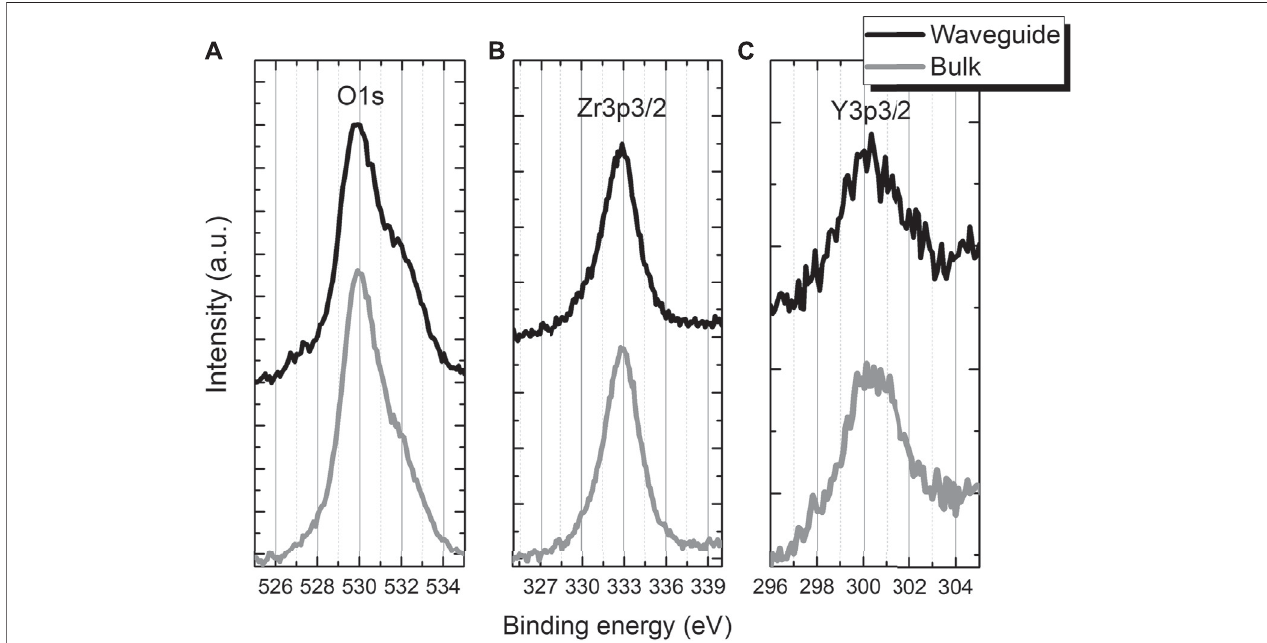
FIGURE 10 | X-ray photoelectron spectra of the nc-YSZ ceramic for both the laser irradiated (waveguide) and the non-laser irradiated (bulk) zones (A) O 1s, (B) Zr 3p3/2 and (C) Y 3p3/2.